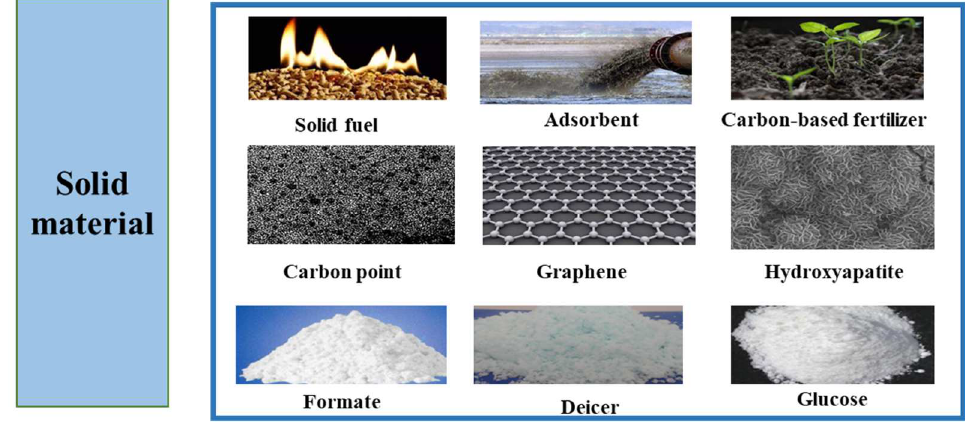
Figure 6. Applications of the solid product obtained by hydrothermal treatment of food waste.